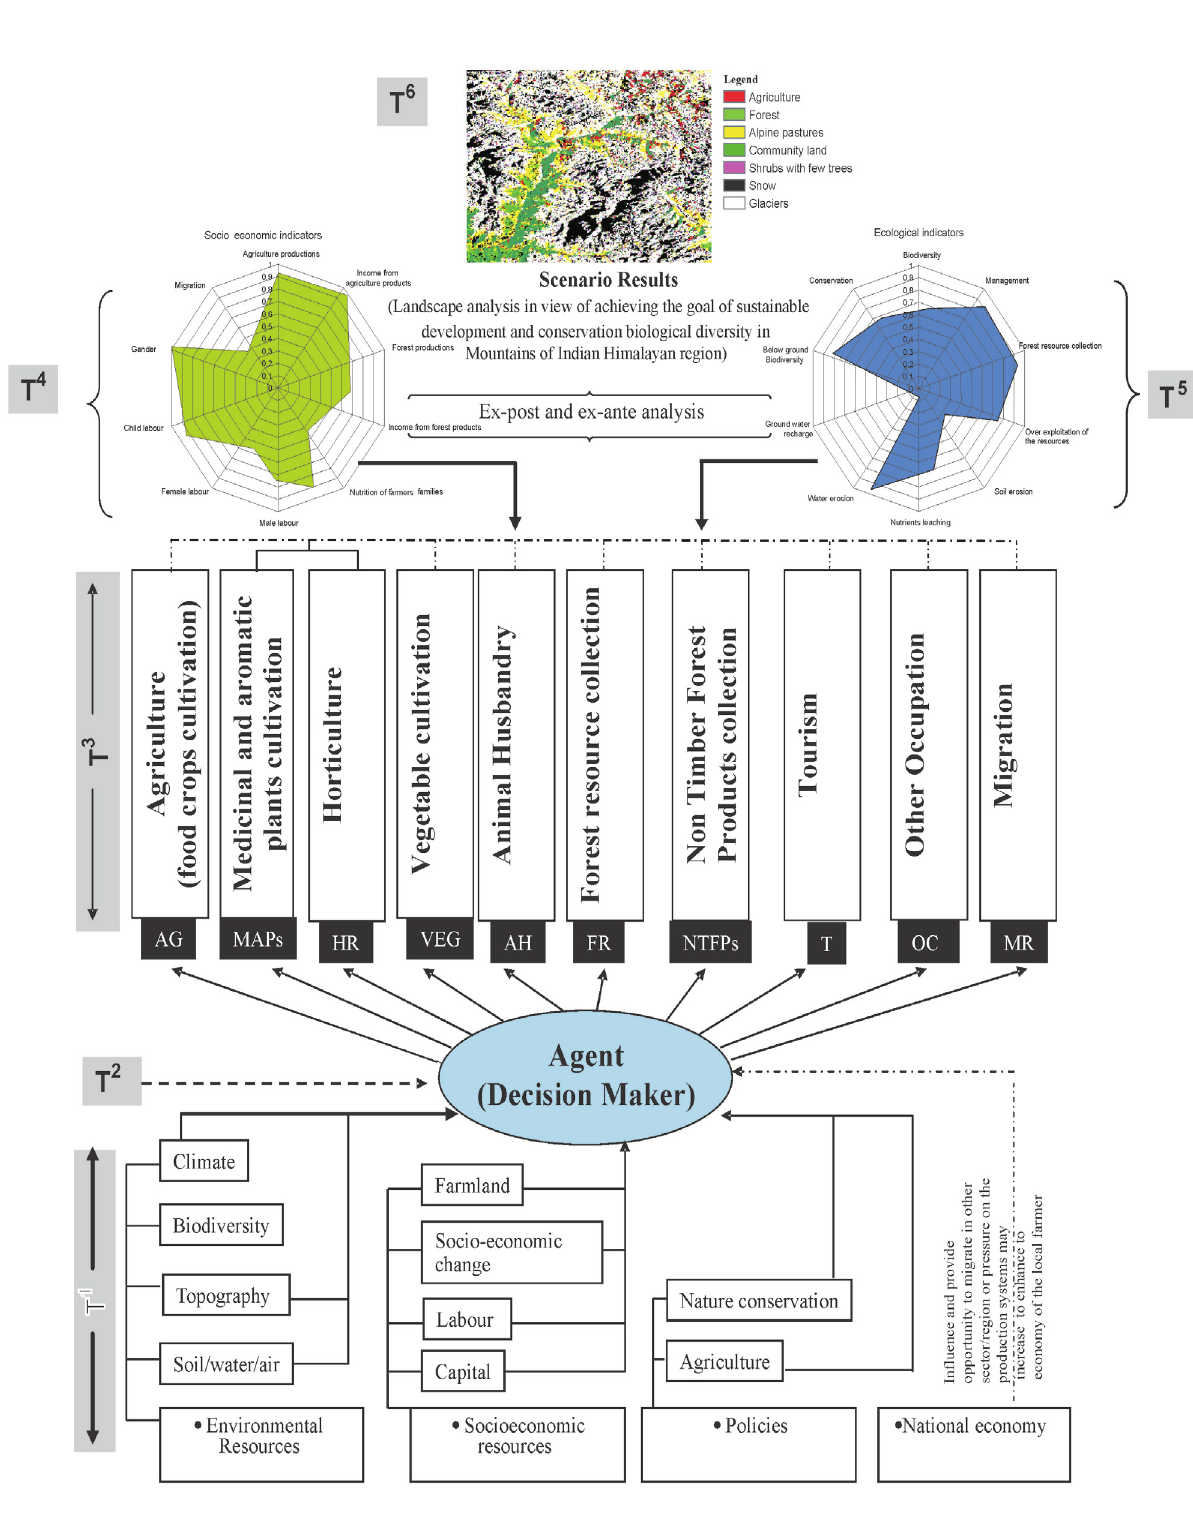
Figure. 3. Development of theoretical model is beginning for development of whole model system MODAM for Himalayan region. (T1, T2, T3, T4, T5 and T6 : modules of theoretical model development) (Nautiyal and Kaechele